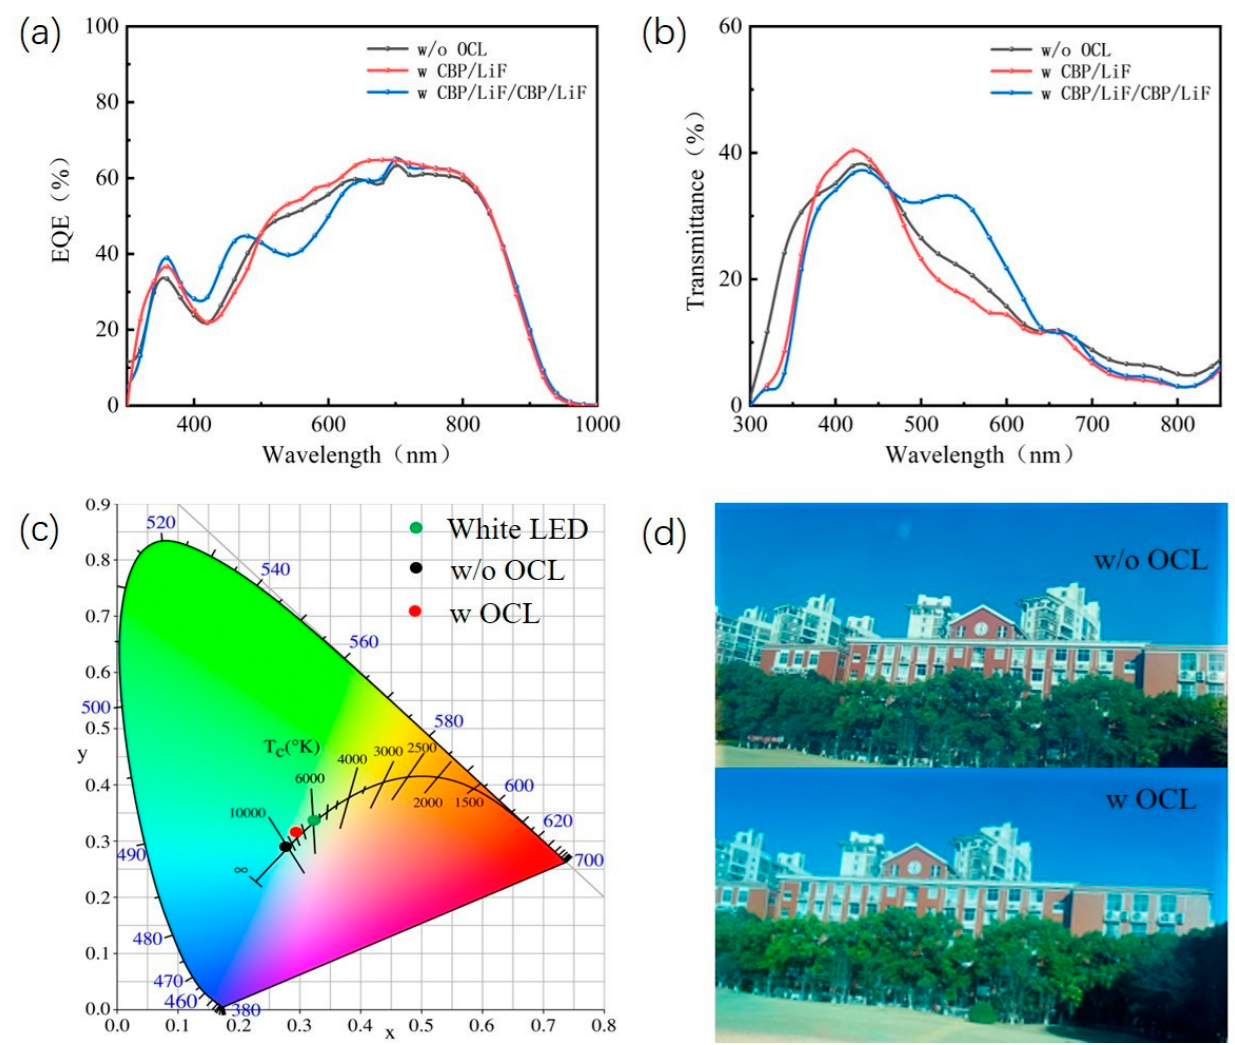
Figure 8. ( a ) The EQE spectra; ( b ) transmission spectra; ( c ) CIE (x, y) coordinates of the ST-OSCs when the weight ratio of PM6 to Y6 is 0.4:1.2. ( d ) Photographs taken through the ST-OSCs with an OCL and without an OCL.